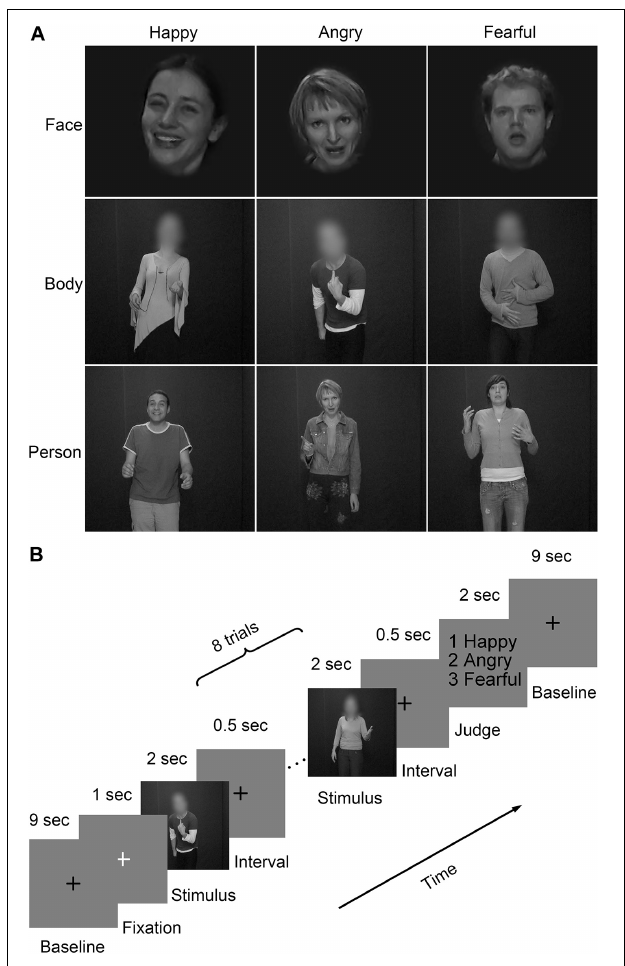
FIGURE 1 | Representative stimuli and paradigm of the experiment design. (A) Three stimulus types (face, body, and whole person) expressing three emotions (happy, angry, and fearful) were used in the experiment. The faces and bodies were masked with Gaussian blur masks; (B) A schematic overview of the presentation timing for emotion judgment task. Participants performed four fMRI runs, each starting and ending with a 10 s fixation baseline period. Emotions expressed by three stimulus types (face, body, and whole-person) were presented in each of the first three runs. The last run, only used emotions expressed by the whole-person. Within each run, 18 blocks of eight trials of the same category were pseudo-randomly presented. These blocks were separated by 10 s fixation interval (a black cross was presented for 9 s, followed by a white cross presented for 1 s to control subjects’ attention). Each trial consisted of a 2 s video, followed by a 0.5 s interval. At the end of each block, participants were asked to make a choice between three emotions using a button press within a 2 s response